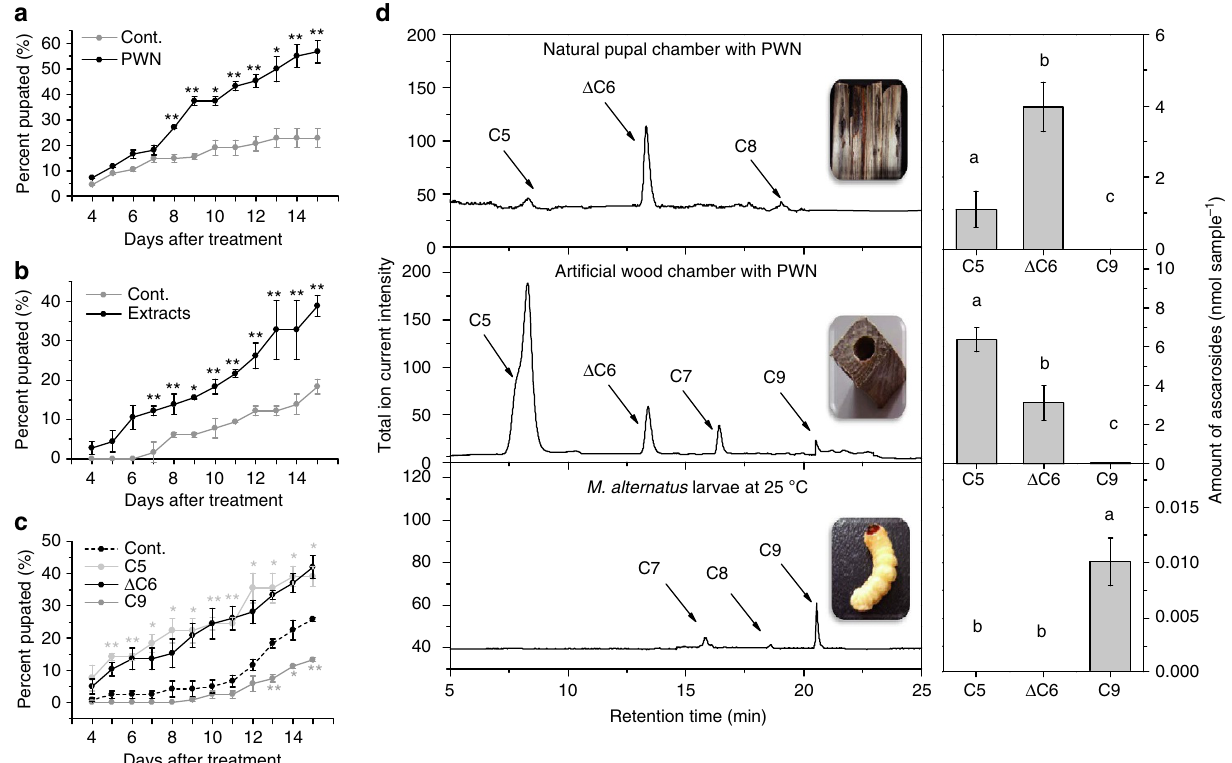
Figure 1 | Effects of PWN L III larvae and ascarosides on beetle development. ( a ) The effect of PWN L III larvae on the time to metamorphosis of the beetles ( n ¼ 20). Values are expressed as mean ± s.e.m. of three independent experiments. * P o 0.05 versus control and ** P o 0.01 versus control (Student’s t -test, unpaired, two-tailed). ( b ) The effect of ethanol extracts from chambers with numerous PWN L III larvae on the time to metamorphosis of the beetle ( n ¼ 20). Values are expressed as mean ± s.e.m. of three independent experiments. * P o 0.05 versus control and ** P o 0.01 versus control (Student’s t -test, unpaired, two-tailed). ( c ) Effects of ascarosides on the time to metamorphosis of the beetle. Asc- D C6 was tested at 3.97nM (the concentration in each natural chamber with about 5,000 L III larvae), asc-C5 at 6.37nM (the concentration in each artificial chamber with about 5,000 L III larvae), and asc-C9 was tested at 0.05nM (the concentration in each beetle larva at 4 (cid:2) C; n ¼ 20). Values are expressed as mean ± s.e.m. of three independent experiments. * P o 0.05 versus control and ** P o 0.01 versus control (Kruskal–Wallis nonparametric test, Mann–Whitney U test). ( d ) Ascarosides detected using LC–MS/MS in extracts from natural chambers with PWN, artificial chambers with PWN and the beetle surface ( n ¼ 20). Values are expressed as mean ± s.e.m. of five independent experiments. P o 0.05 (ANOVA, Tukey’s multiple comparison test). Labels with different letters are significantly different at P ¼